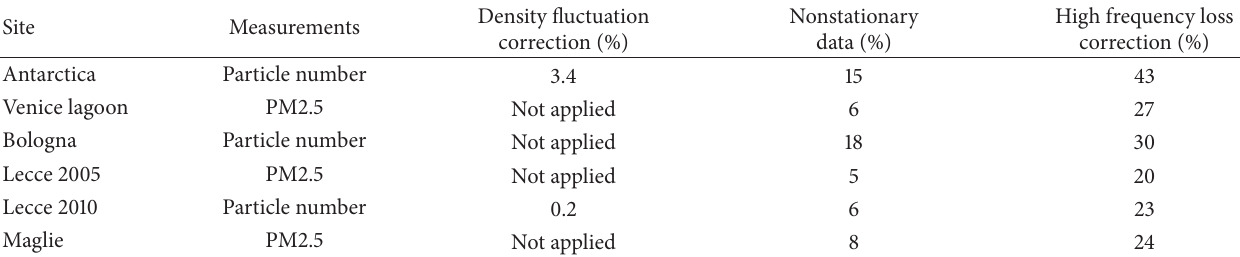
Table 2: Summary of experimental sites with indication of the typology of measurements. The table includes the percentages associated with the different corrections such as density fluctuation correction, high frequency loss correction, and nonstationary data removed.